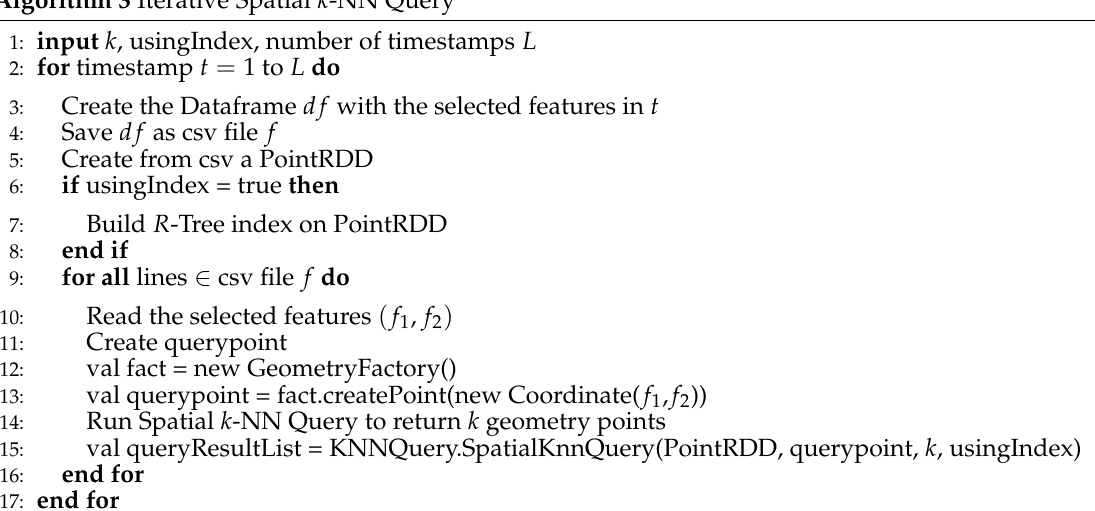
Algorithm 3 Iterative Spatial k -NN Query